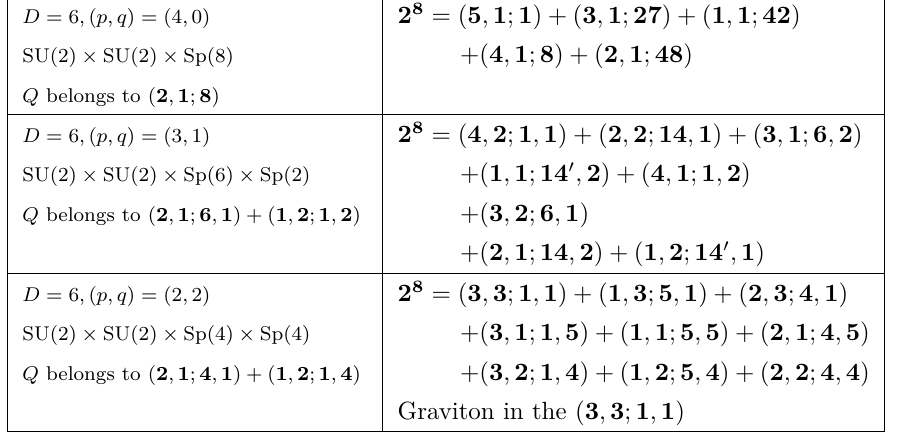
Table 1 . Six-dimensional multiplets with 32